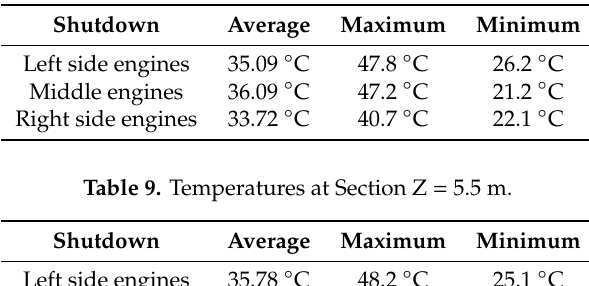
Table 8. Temperatures at Section Z = 2 m.